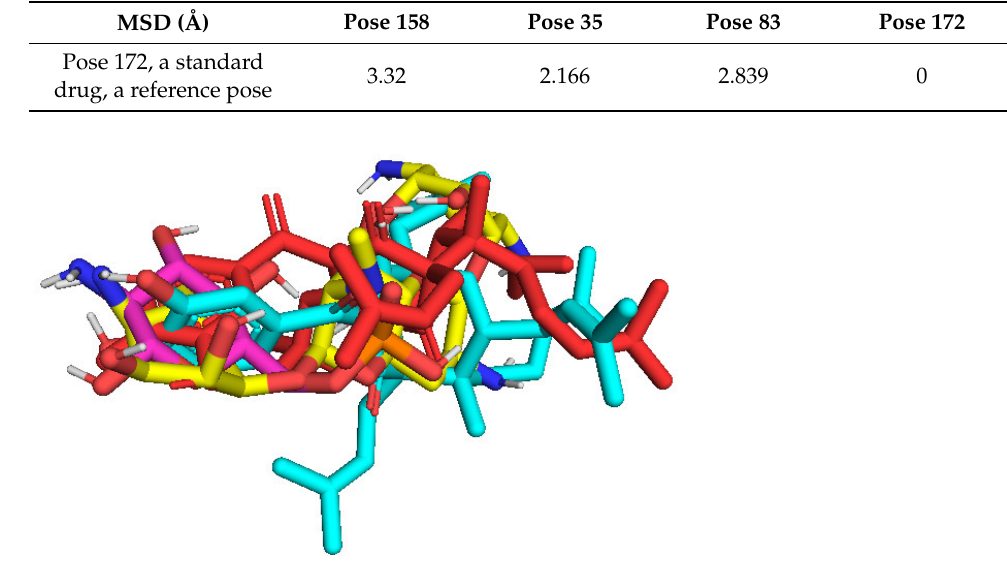
Table 5. The values of RMSD between pairs of poses, with apramycin, a standard drug, as a reference pose.